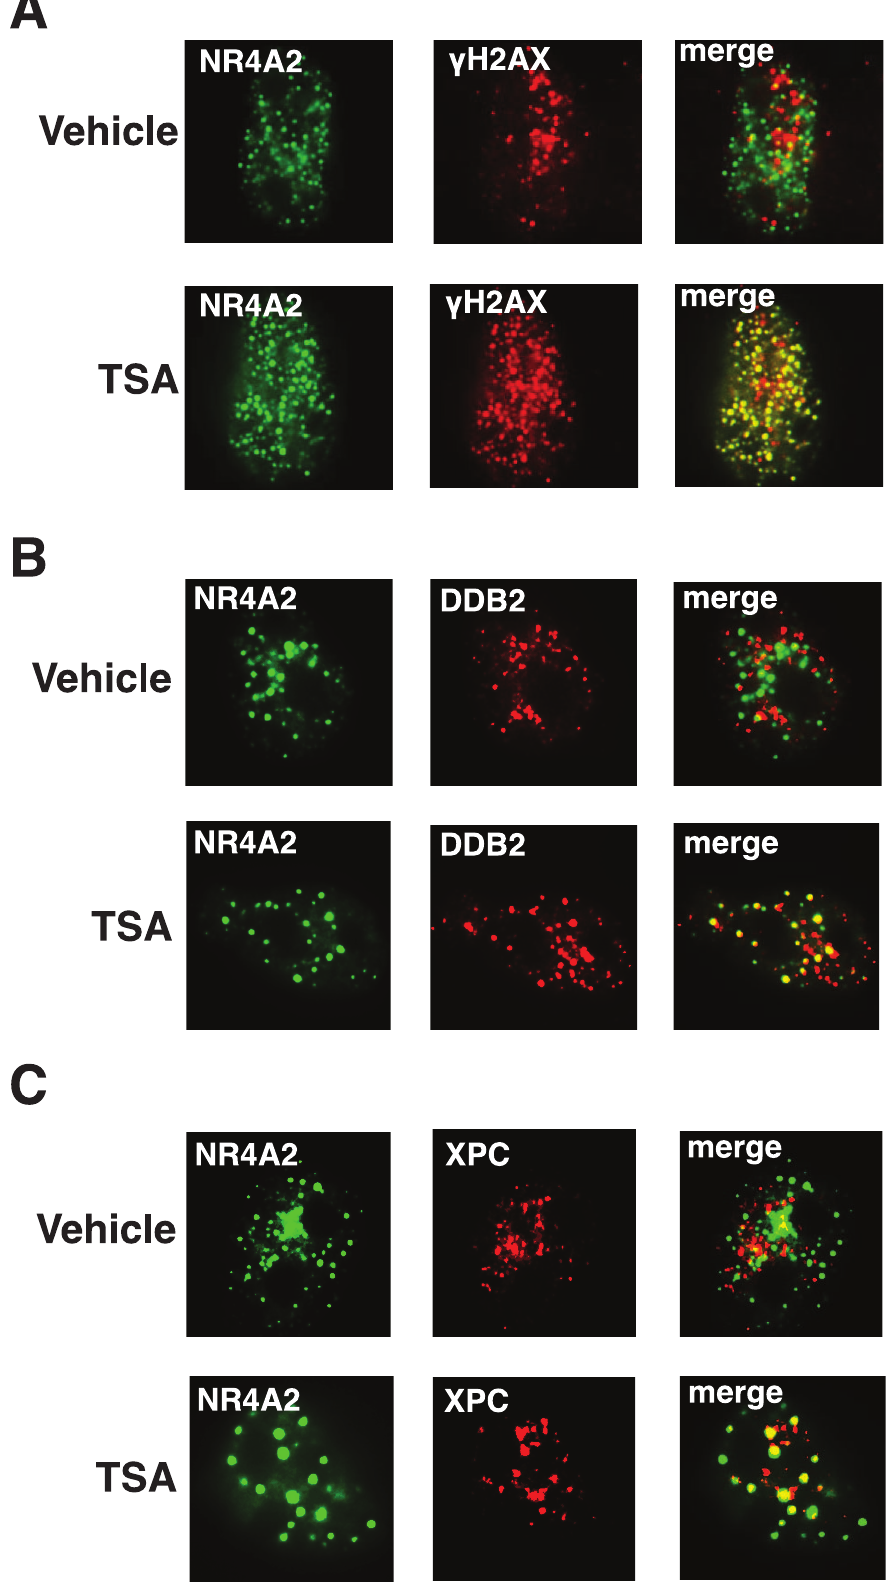
Figure 5. Trichostatin A (TSA) treatment restores co-localisation of NR4A2- D H12 and DNA repair proteins. The co-localisation of the NR4A2- D H12 mutant (green) and ( A ) c H2A.X, ( B ) DDB2 or ( C ) XPC shown in red was performed in the presence of vehicle (upper panels) or TSA